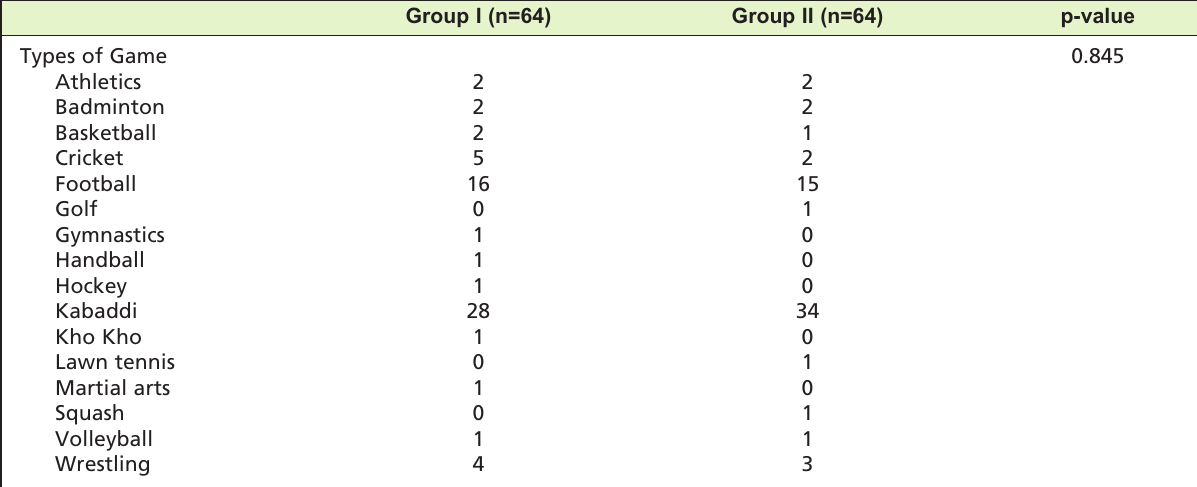
Comparison of type of game played between two groups Table II: